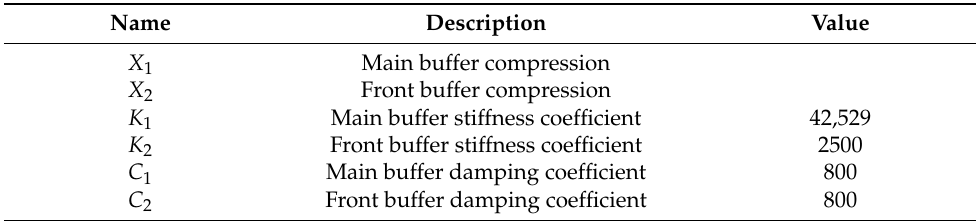
Table 2. Parameters of the buffer.